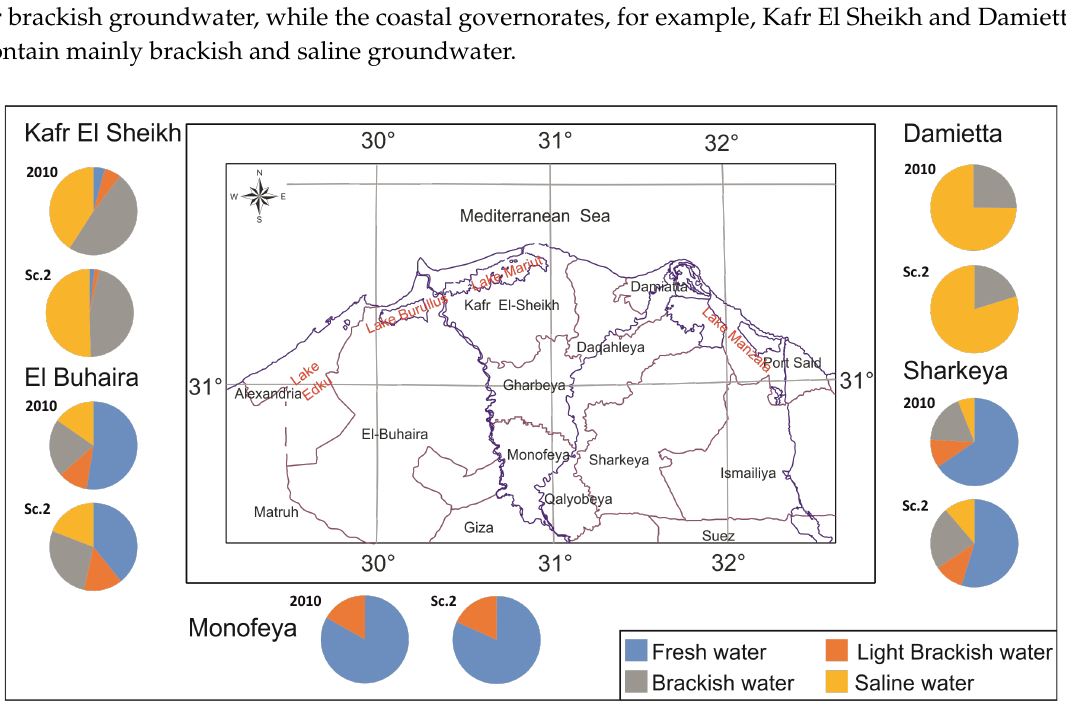
Figure 7. Proportional distribution of the different groundwater types for selected governorates in the current situation and under